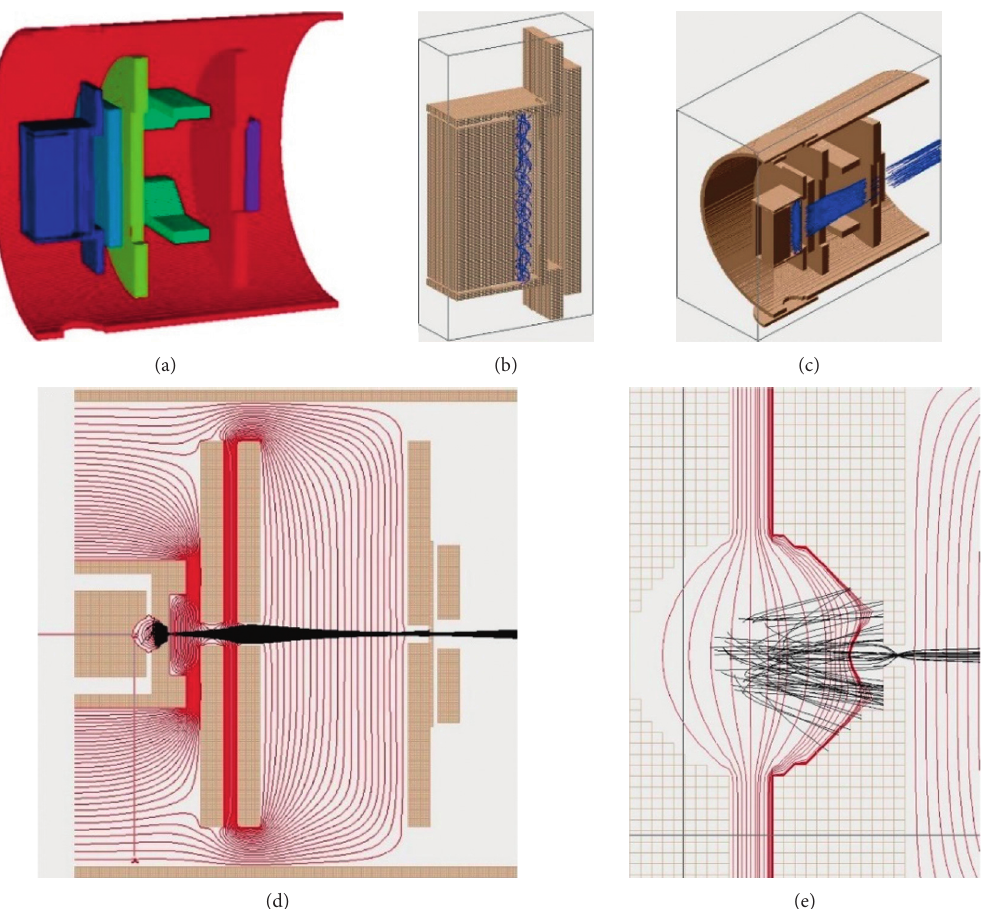
Figure 1: (a) Simulation structure of the designed EI ionization source. (b) Electron trajectory (blue lines) simulation of the designed EI ionization source. (c) Ion trajectory (blue lines) simulation of the designed EI ionization source. (d) Potential contours (red lines) and ion focus effect (black lines) in the EI ionization source. (e) Ion optic focus effect in the ionization chamber.